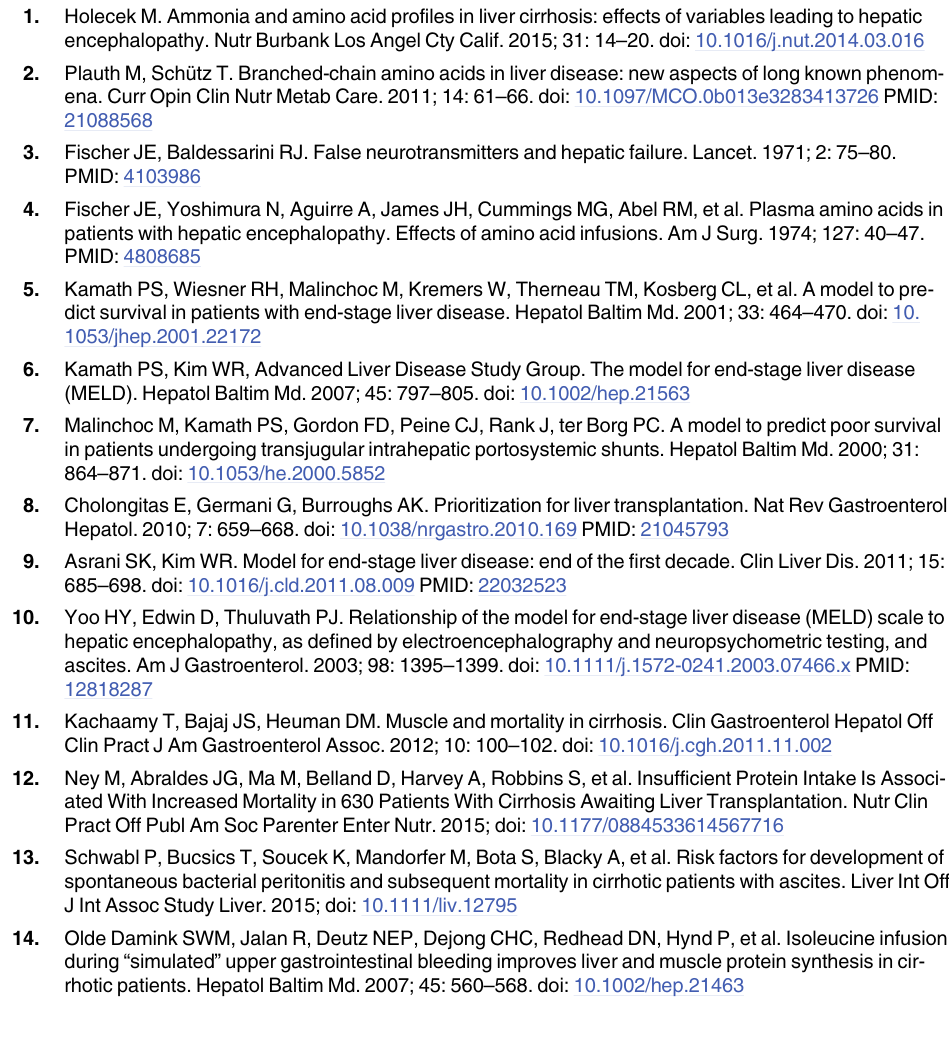
S2 Table. Spearman ’ s rank correlation